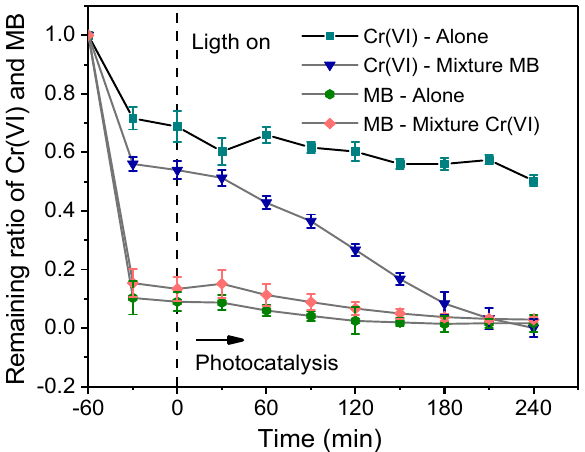
Figure 10. Photocatalysis of Cr(VI) and MB alone or mixed by CNBT under visible light irradiation: C 0Cr(VI) = 5 mg/L, C 0MB = 20 mg/L, m/V = 2.5 g/L, pH = 2.0. ( − 60–0 min: Adsorption process, 0–240 min: Photocatalysis process).